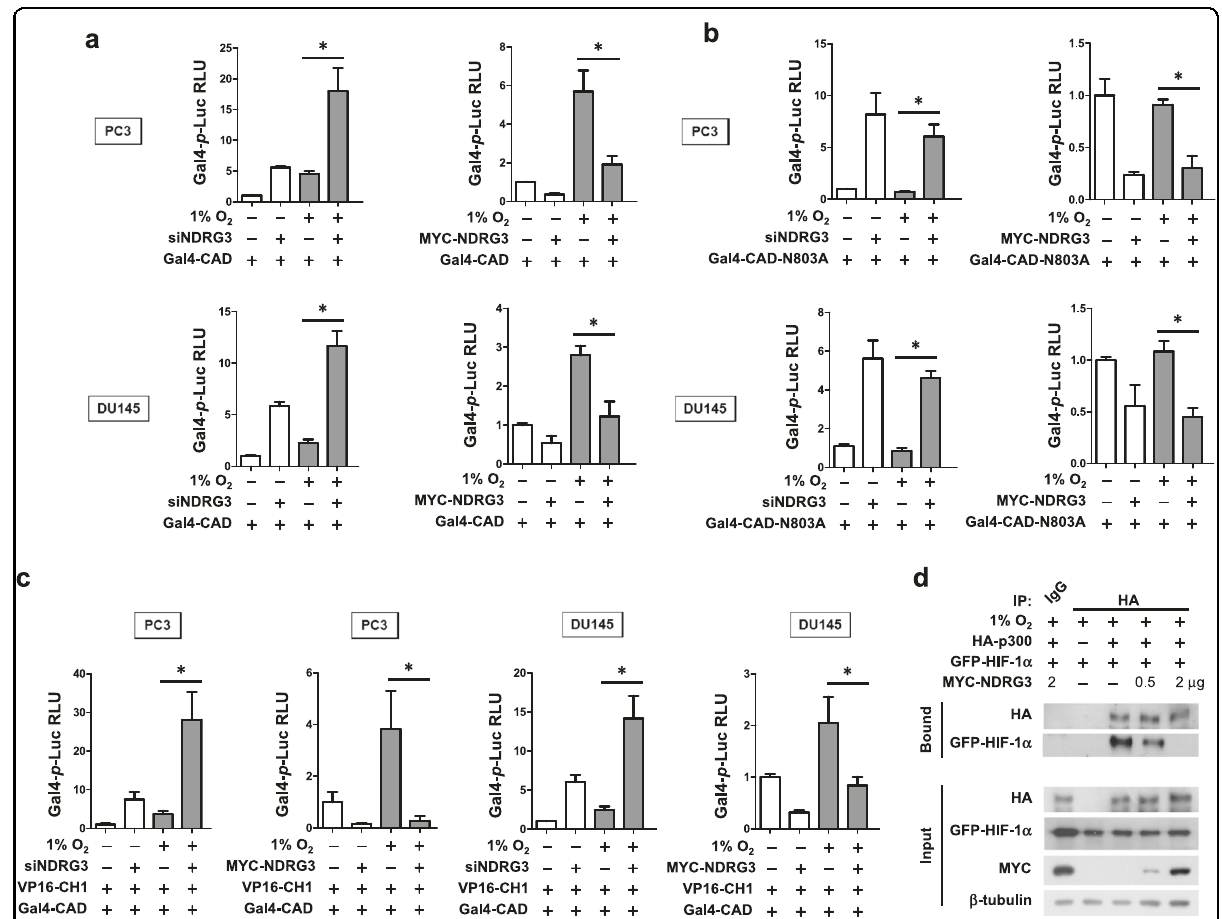
Fig. 5 NDRG3 represses the p300-dependent transcription of HIF-1 α . a , b The MYC-NDRG3 plasmid or siNDRG3 was co-transfected with the Gal4 promoter-Luc reporter plasmid and the Gal4/DBD-HIF-1 α _CAD plasmid or the Gal4/DBD-HIF-1 α _CAD N803A plasmid into PC3 and DU145 cells. Cells were incubated under normoxia or hypoxia for 24 h. c The MYC-NDRG3 plasmid or siNDRG3 was co-transfected with Gal4 promoter-Luc reporter, Gal4/DBD-HIF-1 α _CAD, and p300_CH1-VP16 plasmids. Cells were incubated under normoxia or hypoxia for 24 h. Luciferase activities (means + s.d., n = 3) were normalized to β -galactosidase activities and presented as relative values to the normoxic control. * denotes P < 0.05 between the indicated groups. d PC3 cells were co-transfected with GFP-HIF-1 α , HA-p300, and MYC-NDRG3 (0.5 or 2 μ g). Proteins in cell lysates were immunoprecipitated with an anti-HA antibody and immunoblotted using the indicated antibodies. The experiments were performed three